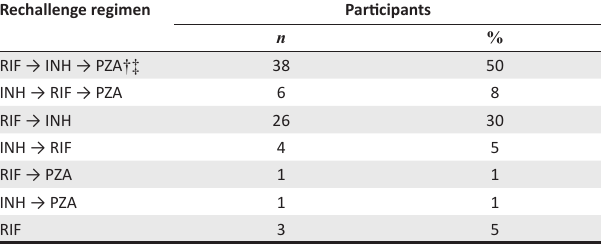
TABLE 3: Sequence of anti-tuberculosis drug